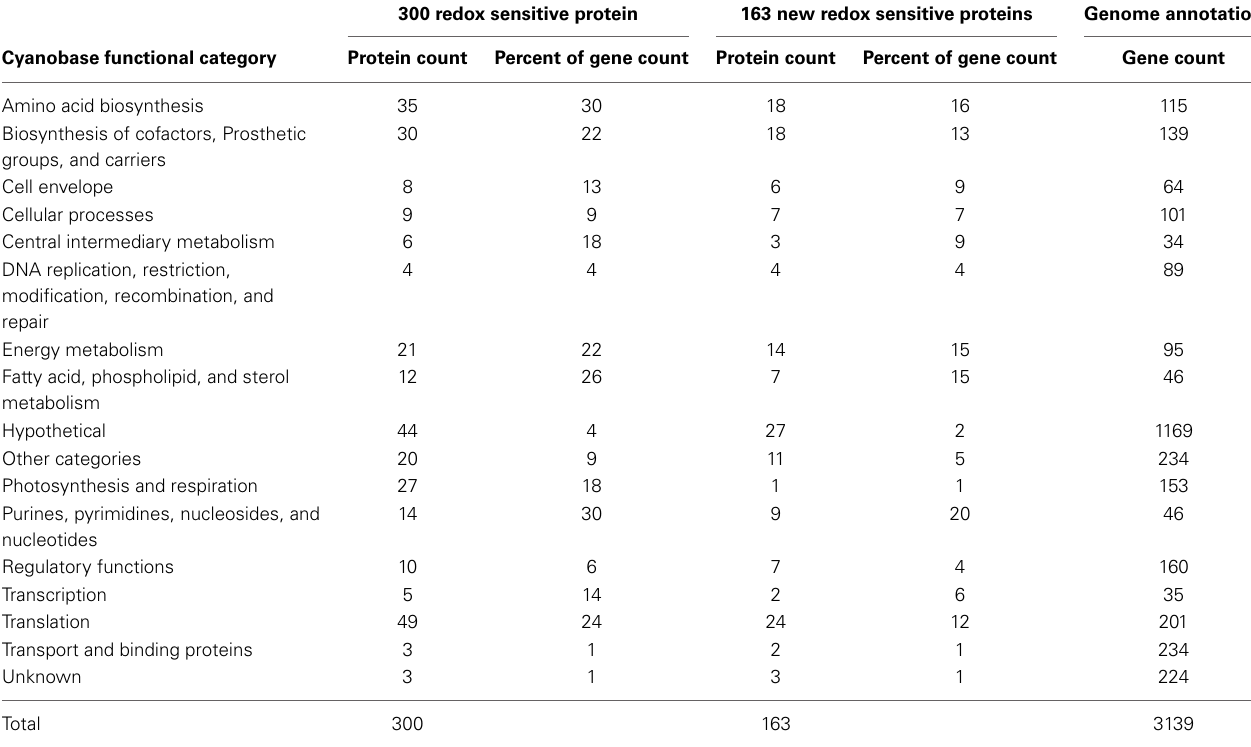
Table 1 | Cyanobase functional categories represented by live-cell probe-labeled proteins identified during light-to-dark switch in Synechococcus